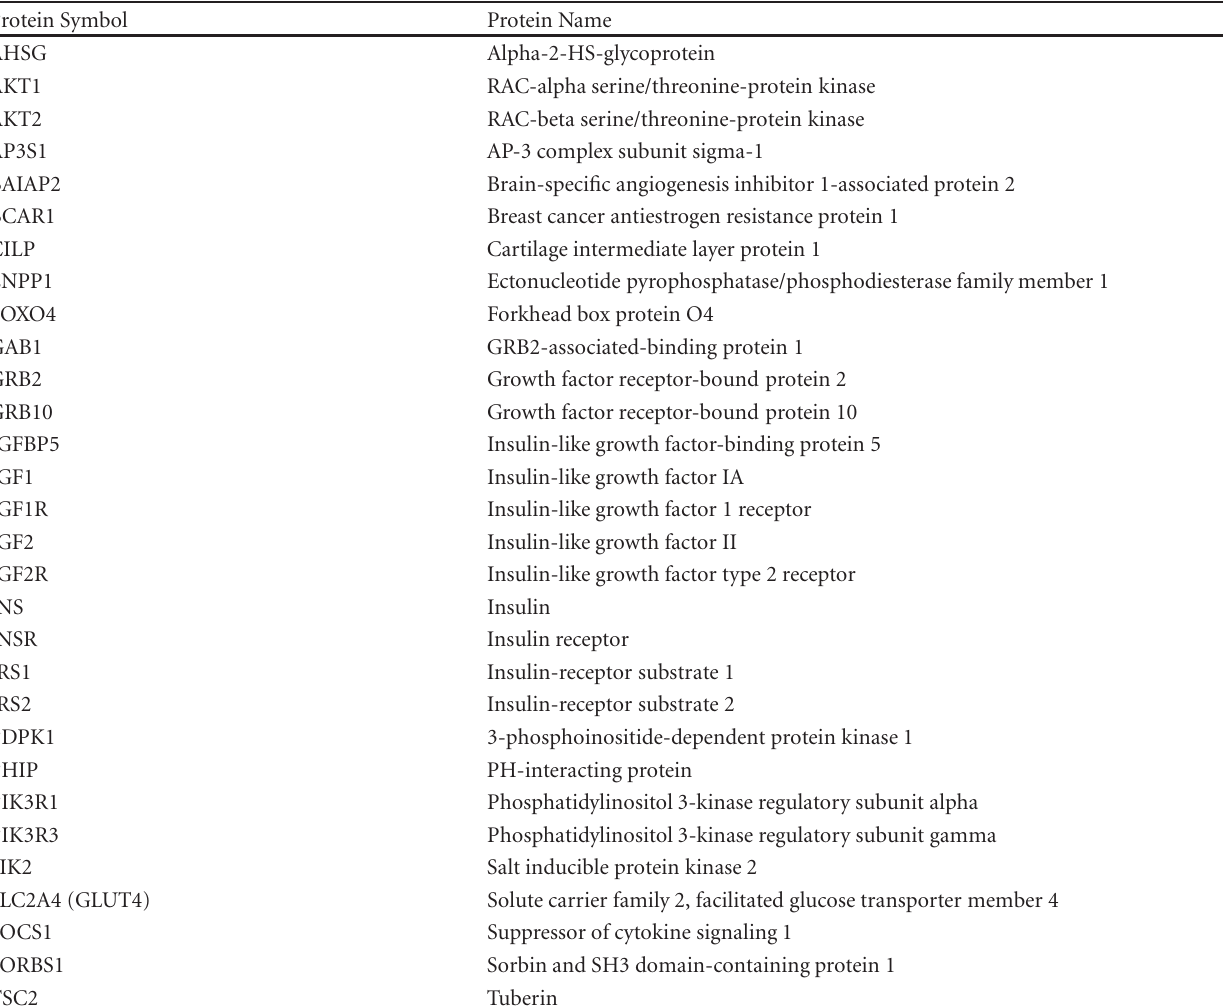
Table 1: Core proteins of the insulin signaling